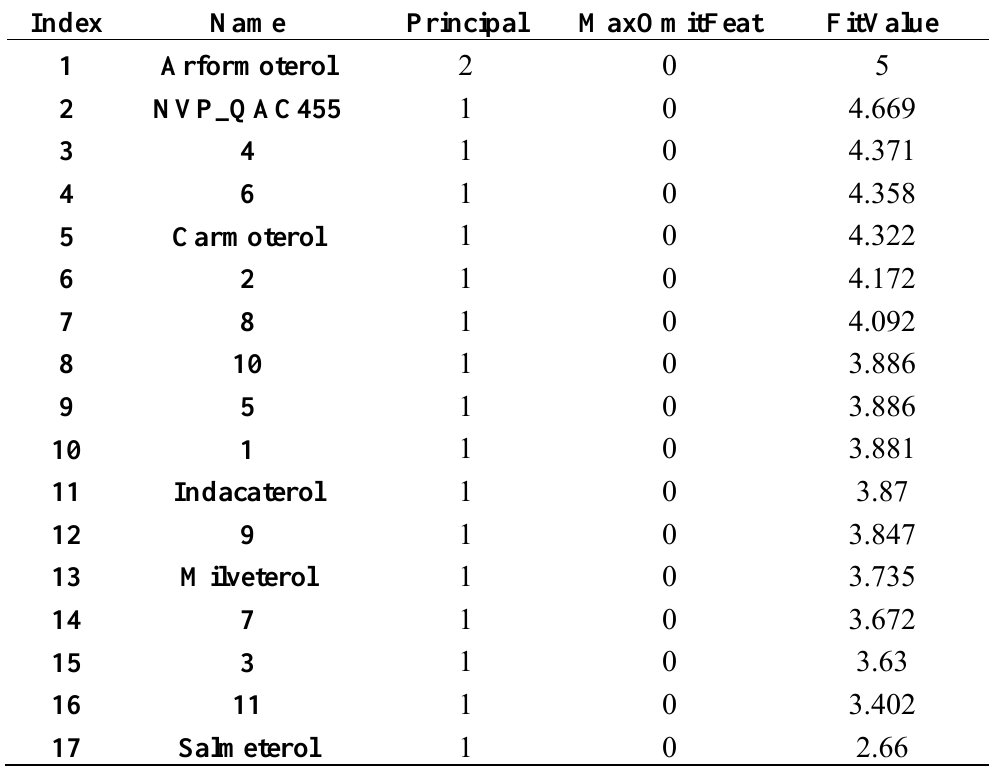
-adrenoreceptor agonists onto Hypo1_I. 2